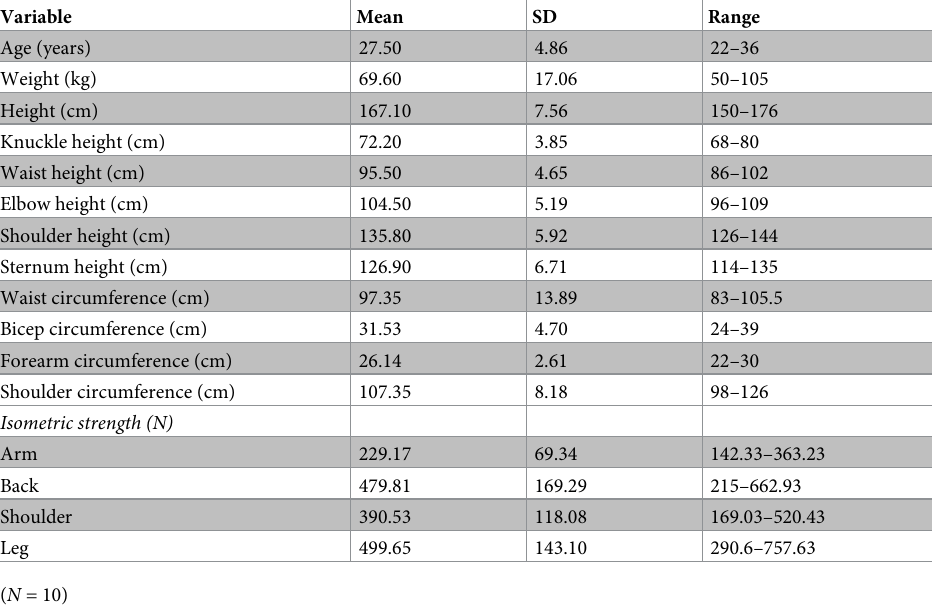
Table 1. Anthropometric and isometric strength measurements of the Malaysian male subjects.